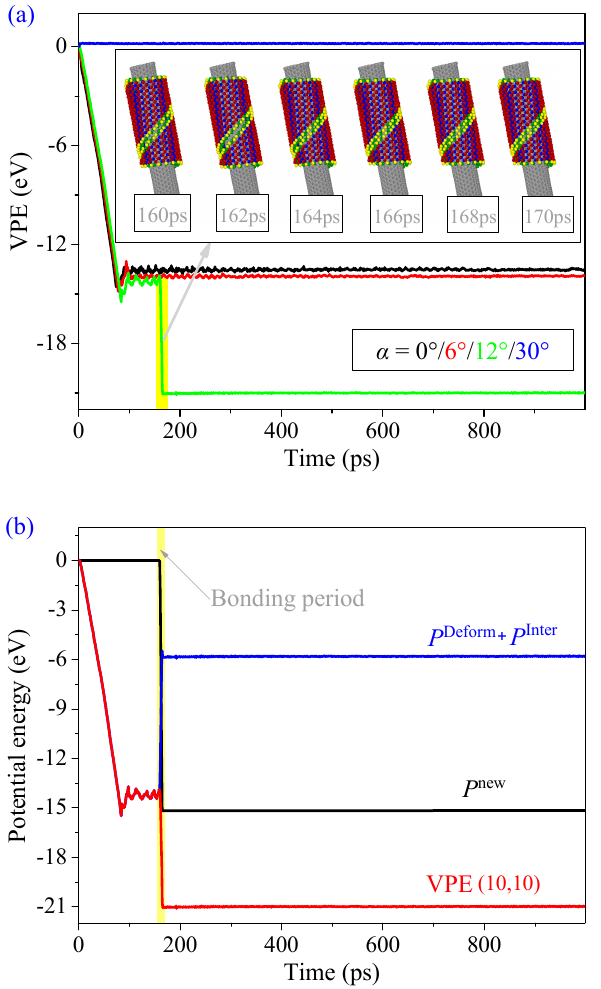
Figure 8. Historical curves of the potential energy of the system and snapshots of the BP on the CNT (10, 10) when L y = 3 nm. ( a ) VPE of the system with different α . ( b ) Combination of VPE with α = 12 ◦ . Table 5. Final states of the BP component on CNTs when α < 0 ◦ and L y = 0 nm.